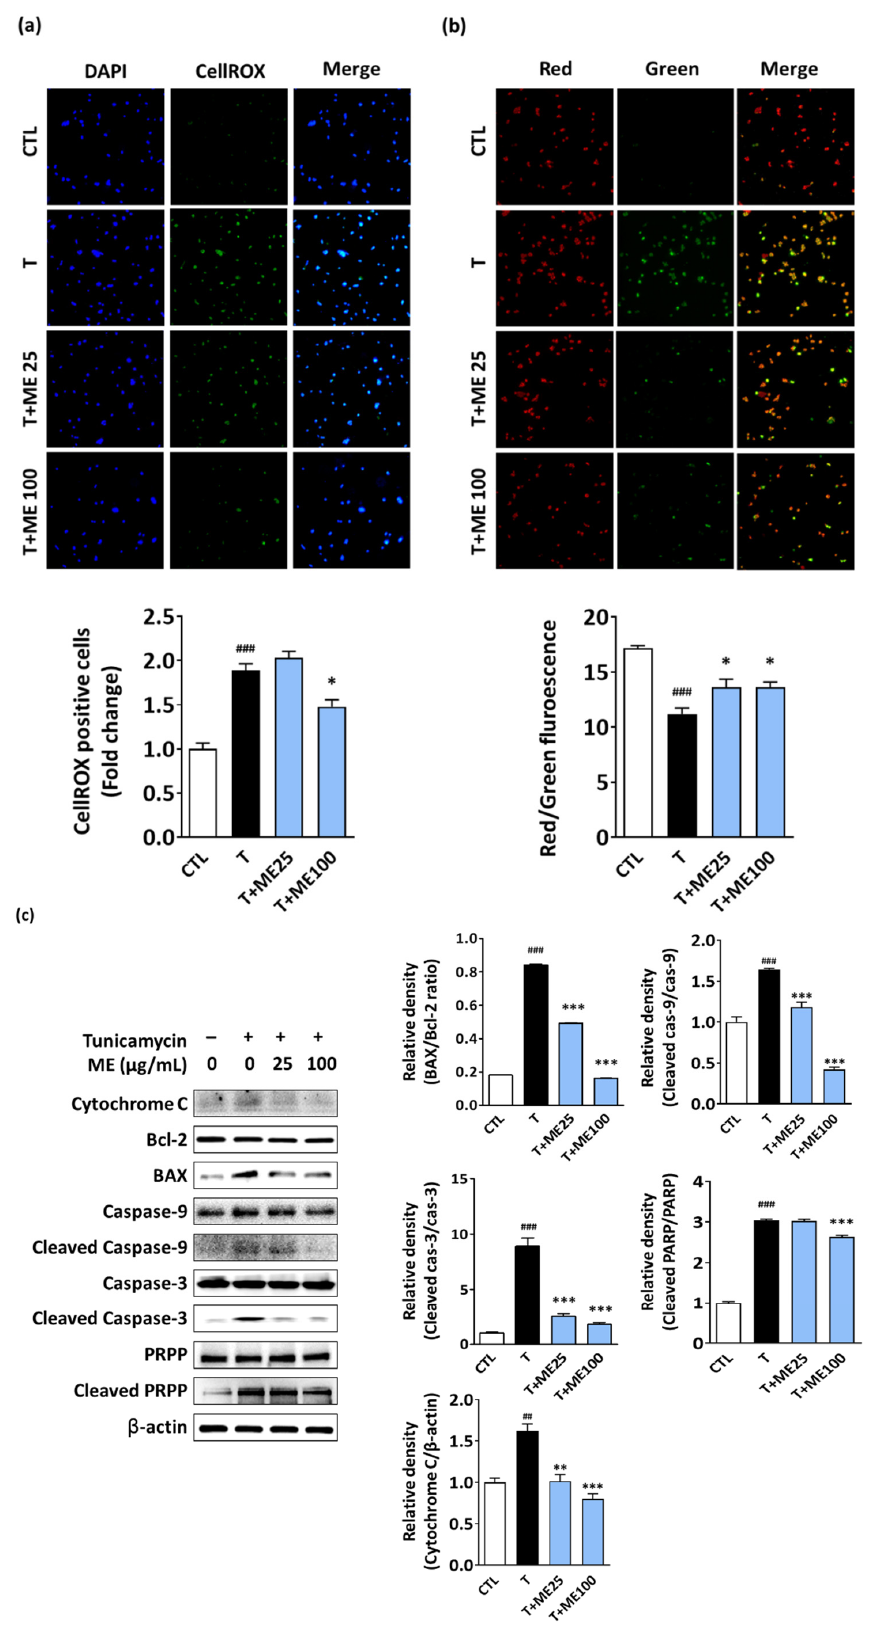
Figure 4. ME ameliorated ROS formation, mitochondrial dysfunction, and apoptotic signaling induced by tunicamycin treatment in NIT-1 pancreatic β -cells. ( a ) Effect of ME on the tunicamycin-induced intracellular ROS levels.